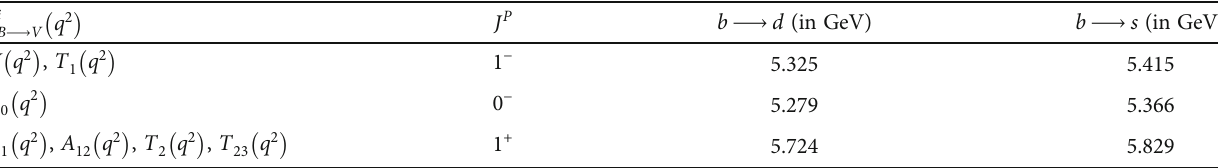
− ðð m − m Þ / m Þ A and T = ð m / ð n · p ÞÞ T 1 2 23 B V B B